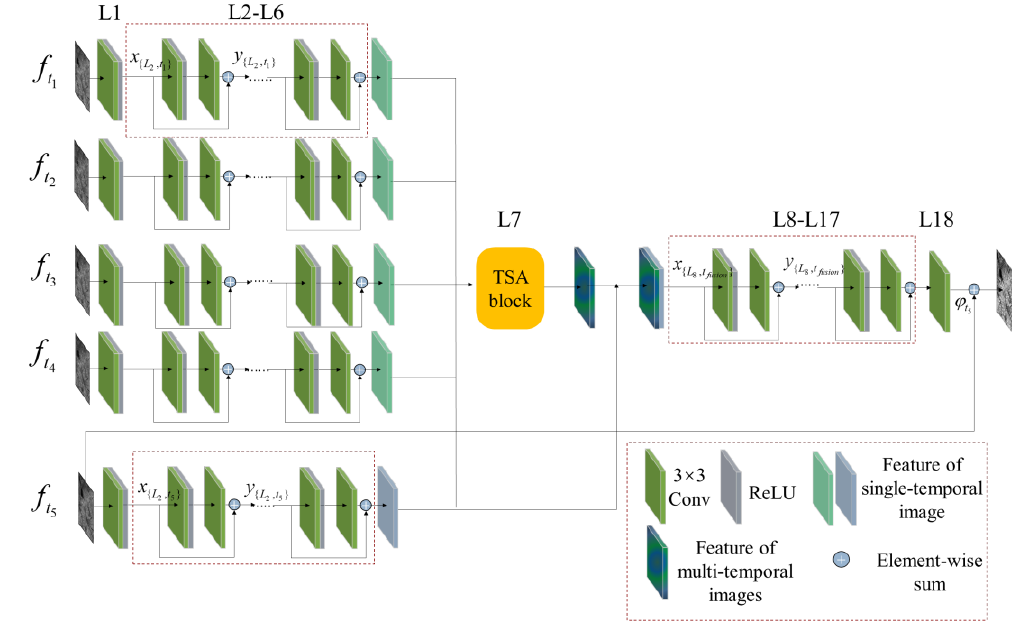
Fig. 1 the overall Frameworks of MSAR-CNN structures which consist of a convolutional layer along with rectified linear unit (ReLU) activation function and five residual blocks. And then TSA is used to fusion the spatio-temporal information. Ten series residual blocks with a convolution in the last act as reconstruction layers on the concatenated features of fusion and target. Lastly, the despeckling target SAR image is generated by the sum of the output residual and the input target image. The detailed configuration of the proposed MSAR-CNN is provided in Table 1.